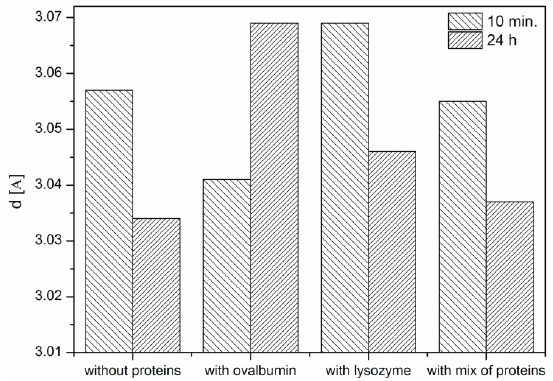
Figure 6. Interplanar spacing d of CaCO 3 samples after 10 min and 24 h. Protein concentration—0.1%.